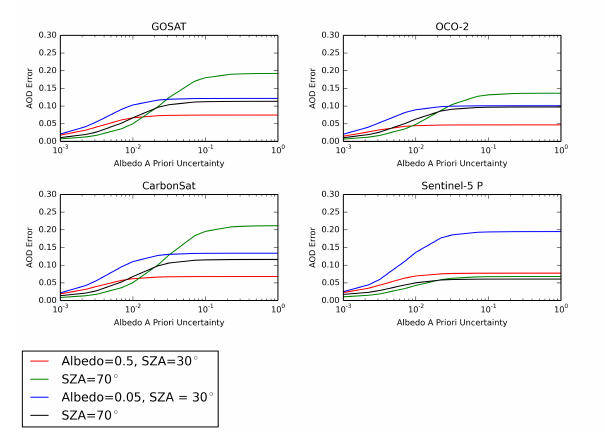
Figure 10. AOD and height errors for the parameterised aerosol retrievals for the combined aerosol scenarios A + B, A + C and B + C. In the top row the horizontal lines indicate the true AOD values for each case, i.e. the sum of both layers. In the bottom row they show the heights of each individual layer as a reference noting that the prior value for each scenario is the lowest layer height.